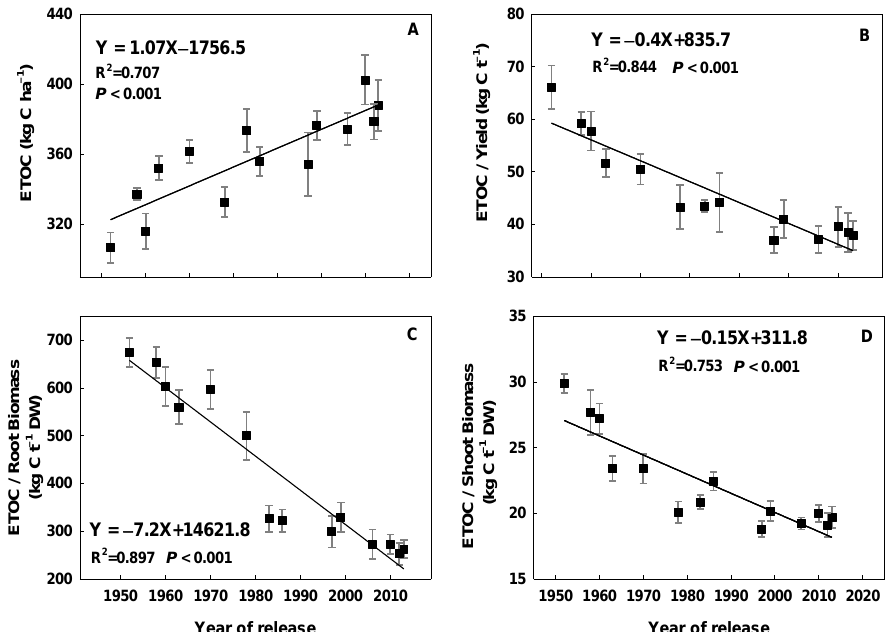
Figure 3. Changes in total organic carbon in root exudation ( A ) and its ratio to yield ( B ), root biomass ( C ), and shoot biomass ( D ) during japonica rice cultivar renewal. Solid squares indicate the mean value of two experimental years for each cultivar, and error bars indicate the standard errors of the mean. Solid lines indicate linear regression lines.